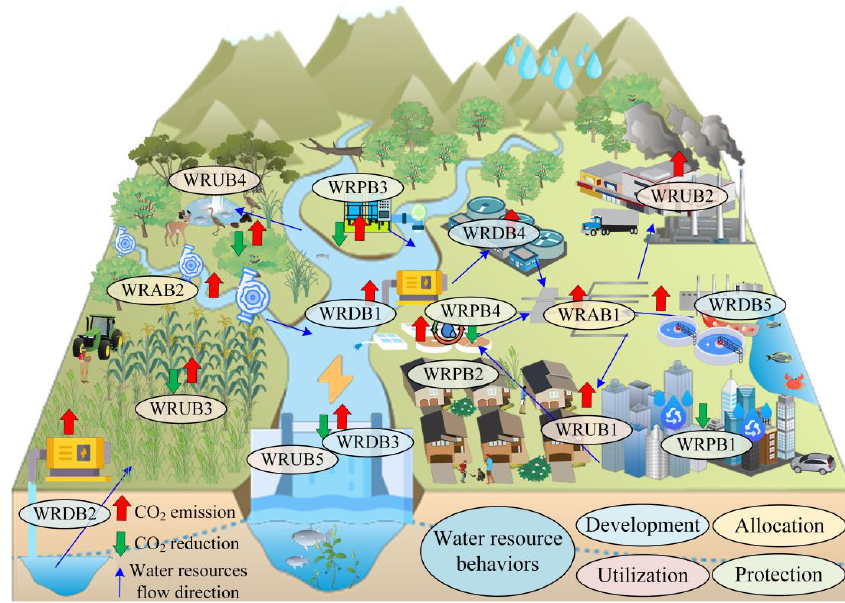
Figure 2. Schematic diagram of CEE accounting for WRBs.